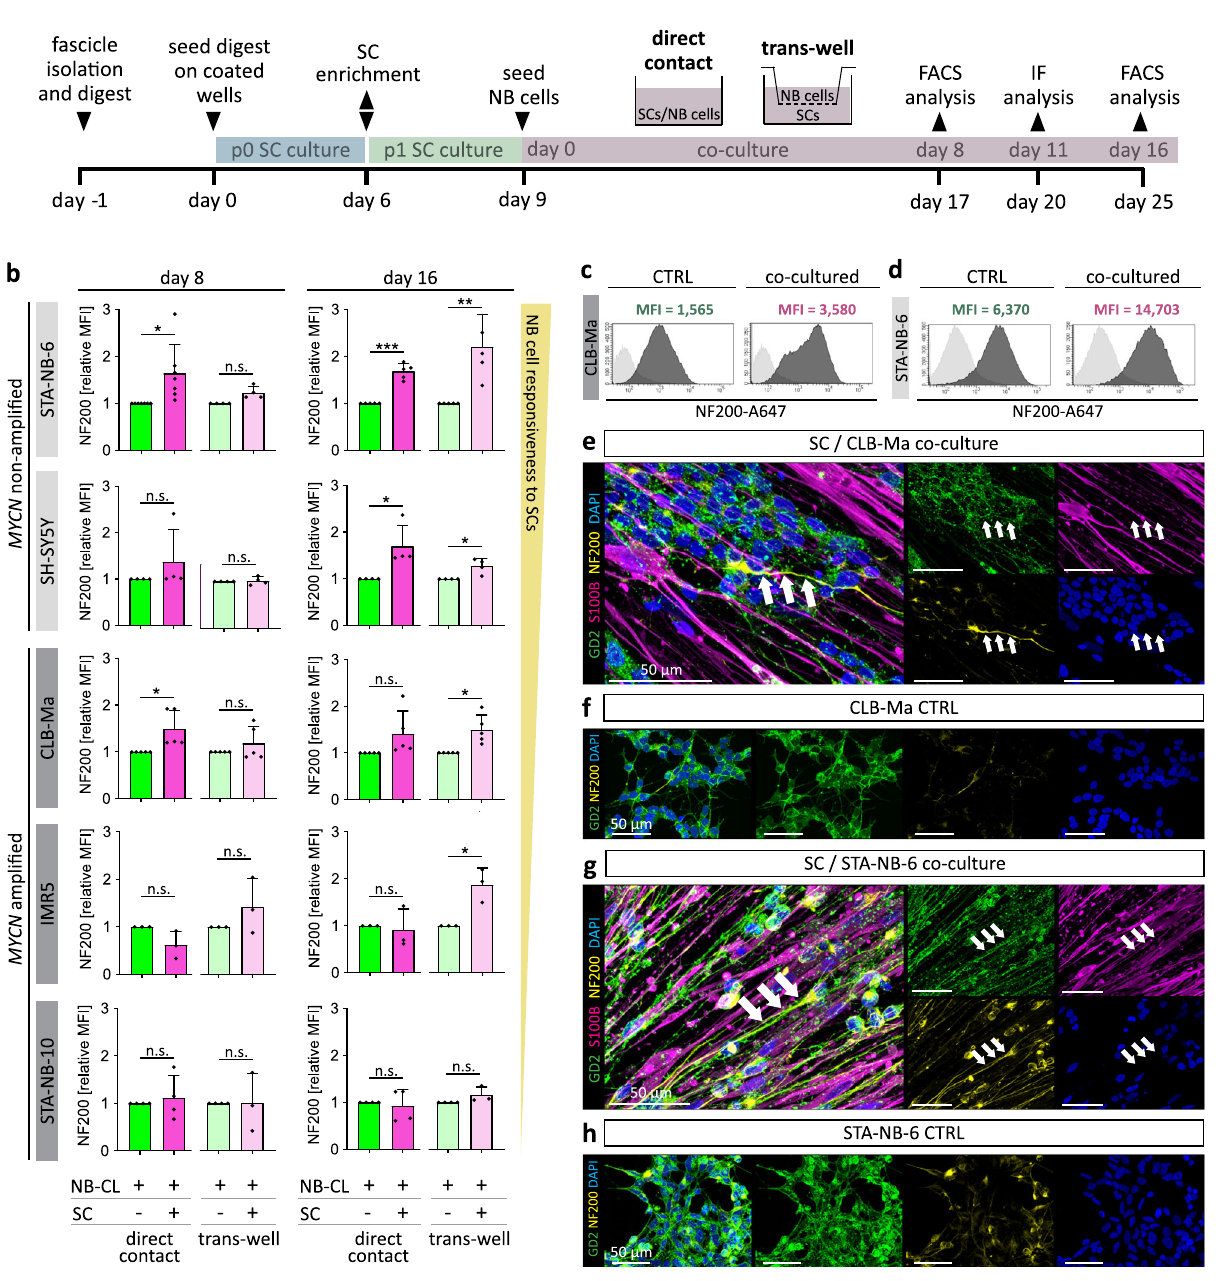
Fig. 4 Neuronal differentiation analysis of neuroblastoma cell lines in response to repair-related SCs in vitro. a Re fi ned SC/NB cell co-culture set up including direct and trans-well co-cultures. Three NB cell lines and two NB cell short-term cultures were co-cultured with primary repair-related SCs and NF200 expression levels were analyzed by fl ow cytometry (FACS) and immuno fl uorescence (IF). b Bar diagrams show the normalized mean fl uorescence intensity (MFI) of NF200 ± SD in GD2 + /S100B - NB cells upon direct co-cultures (STA-NB-6, p = 0.033; SH-SY5Y, p = 0.363; CLB-Ma, p = 0.048; IMR5, p = 0.146; STA-NB-10, p = 0.666) and trans-well co-cultures (STA-NB-6, p = 0.042; SH-SY5Y, p = 0.816; CLB-Ma, p = 0.331; IMR5, p = 0.331; STA-NB-10, p = 0.988) with SCs at day 8 as well as direct co-cultures (STA-NB-6, p = 0.001; SH-SY5Y, p = 0.049; CLB-Ma, p = 0.132; IMR5, p = 0.762; STA-NB-10, p = 0.713) and trans-well co-cultures (STA-NB-6, p = 0.017; SH-SY5Y, p = 0.041; CLB-Ma, p = 0.023; IMR5, p = 0.050; STA-NB-10, p = 0.242) with SCs at day 16. STA-NB-6: day 8 direct co-culture n = 7, trans-well n = 4, day 16 direct co-culture n = 5, trans-well n = 4; SH-SY5Y: n = 4; CLB-Ma: n = 5; IMR5: n = 3; STA-NB-10: direct co-culture n = 4; trans-well n = 3. A paired two-tailed Student ’ s t-test comparing against the control was performed. n refers to the number of independent experiments; * p ≤ 0.05; ** p ≤ 0.01; *** p ≤ 0.001; n.s. not signi fi cant. Representative FACS histograms show the unstained controls (light grey) and the MFI of NF200 in control and co-cultured ( c ) CLB-Ma and ( d ) STA-NB-6 cells (dark grey) at day 16. FACS gating strategy is detailed in Supplementary Fig. 7a. Representative IF images of co-cultured CLB-Ma cells ( e ) and STA-NB-6 ( g ) cells stained for NF200, S100B, GD2 and DAPI at day 11 of direct co-culture and respective NB cell controls stained for GD2, NF200, and DAPI ( f , h ); arrows indicate long neuritic processes of NB cells strongly positive for NF200 in co-cultures. Stainings were performed on NB cell controls and corresponding co-cultures with SCs derived from three independent donors.